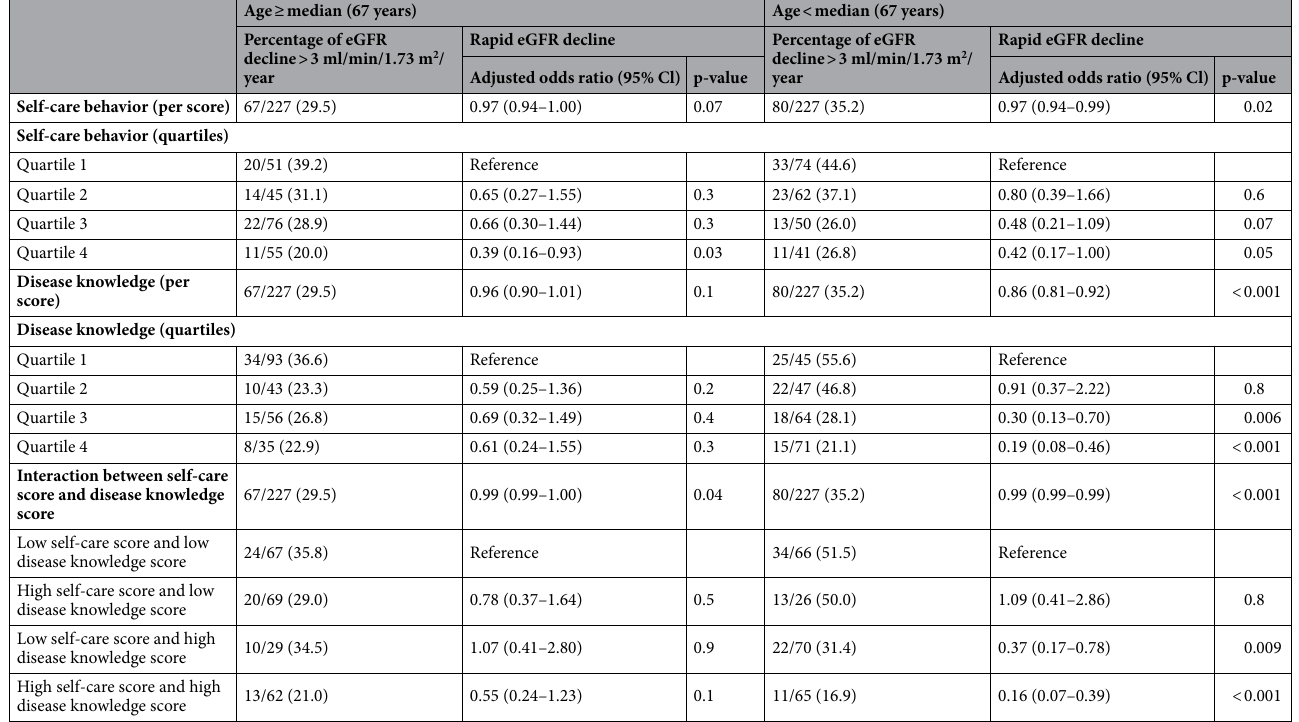
Table 4. The adjusted risks for rapid eGFR decline (eGFR decline > 3 ml/min/1.73 m 2 /year) within 1 year prior to questionnaire examination in study patients stratified by age according to self-care behavior and disease knowledge scores. Adjusted model of self-care behavior and disease knowledge in rapid eGFR decline included age, sex and all variables in Table 1 whose p-value were < 0.05 including diabetes mellitus, hemoglobin, baseline estimated glomerular filtration rate, and log-formed urine protein-creatinine ratio in unadjusted model. Self- care score quartile cut at 59, 67 and 72. Disease knowledge score quartile cut at 18, 22 and 25. Low self-care as less than median of self-care score; high self-care as above median of self-care score. Low disease knowledge as less than median of disease knowledge score; High disease knowledge as above median of disease knowledge